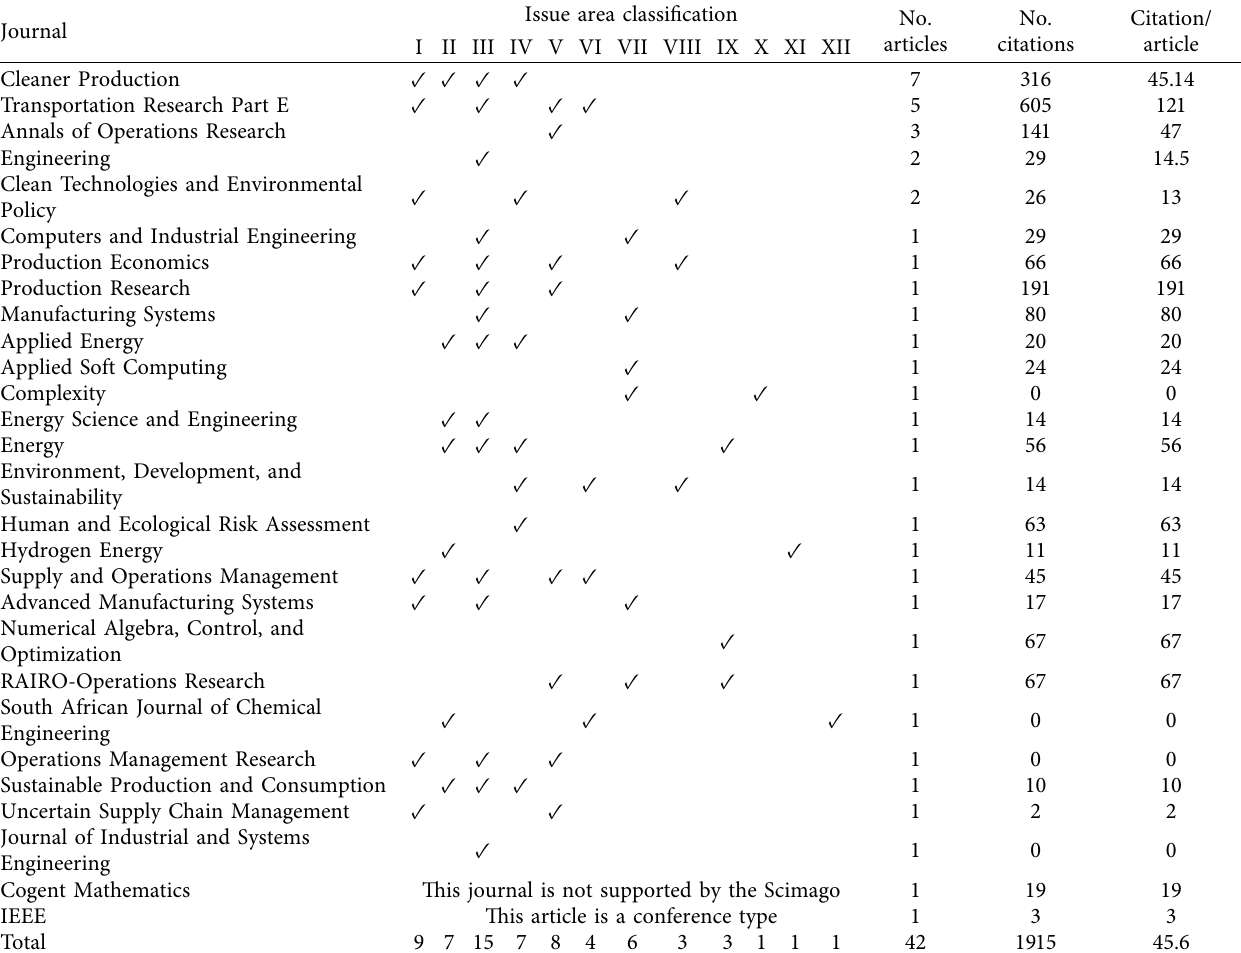
Table 7: Distribution of articles in each